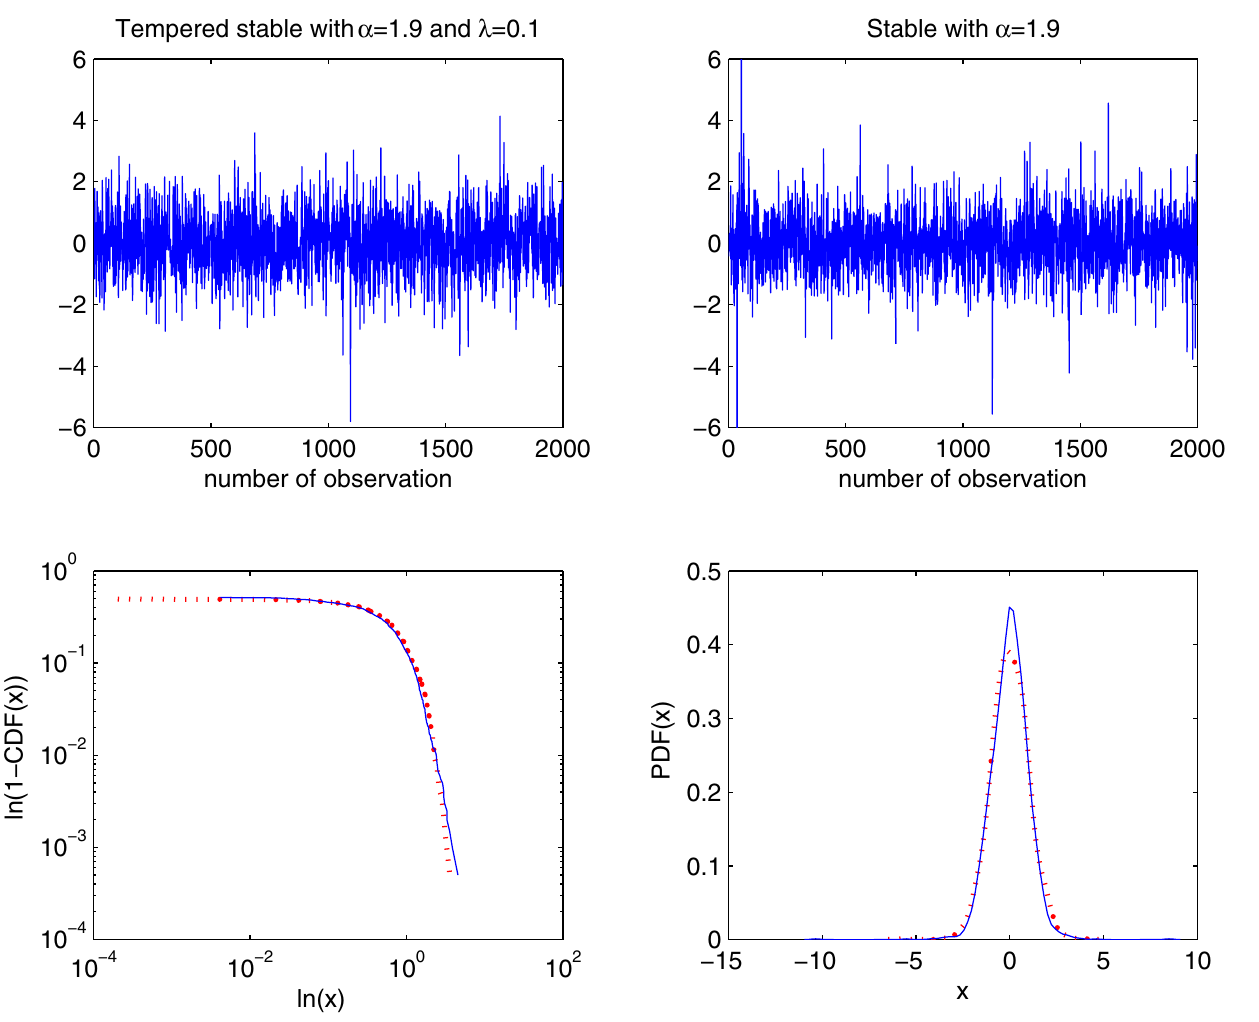
Fig 3. Simulated samples from the symmetric tempered stable distribution with α = 1.9 and λ = 0.1 (top left panel) and symmetric stable distribution with α = 1.95 and σ = 1 (top right panel), and their empirical tails in log-log scale (bottom left panel) and PDFs (bottom right